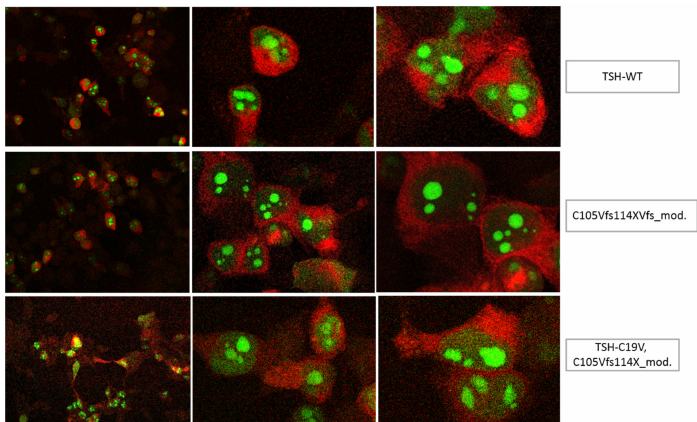
Figure A2. Confocal microscope images showing TSH expression at 20 × , 40 × and 63 × magnification. HEK293 cells were transfected with the α - and β -subunit (the latter cloned into the nAmCyan-P2A-mCherry vector) of WT-TSH and modified TSHB mutants. The transfection e ffi ciency and subsequent expression is shown in the green fluorescence (AmCyan). When comparing the WT-TSH and the two modified frameshift mutations no di ff erence regarding the expression was